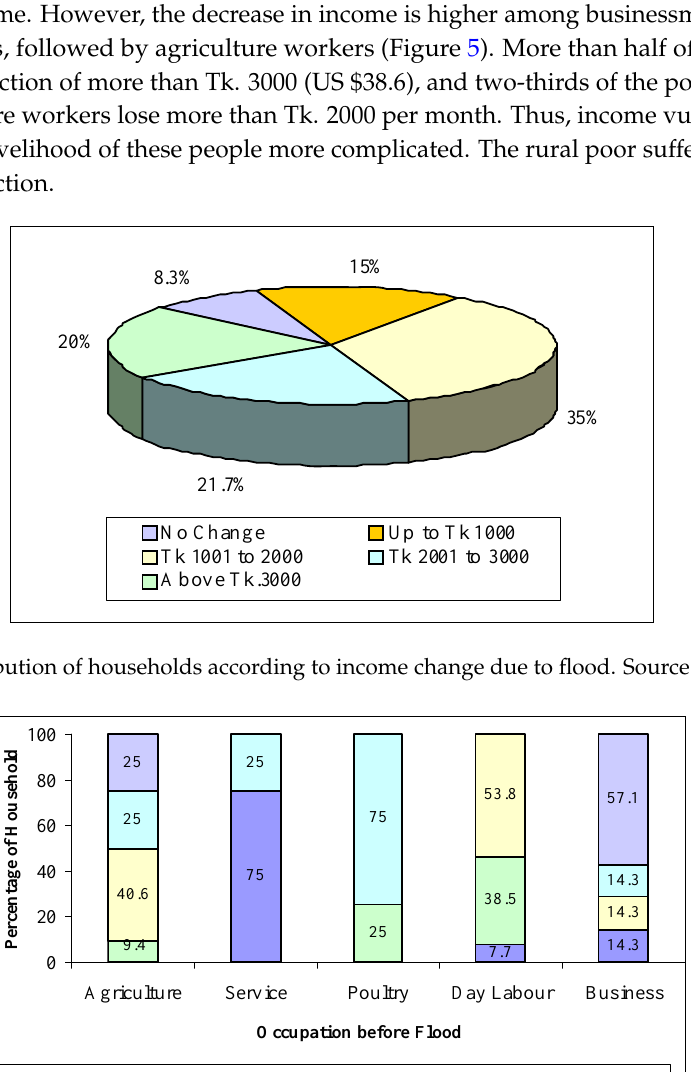
Table 3. Approaches followed to financially cope.